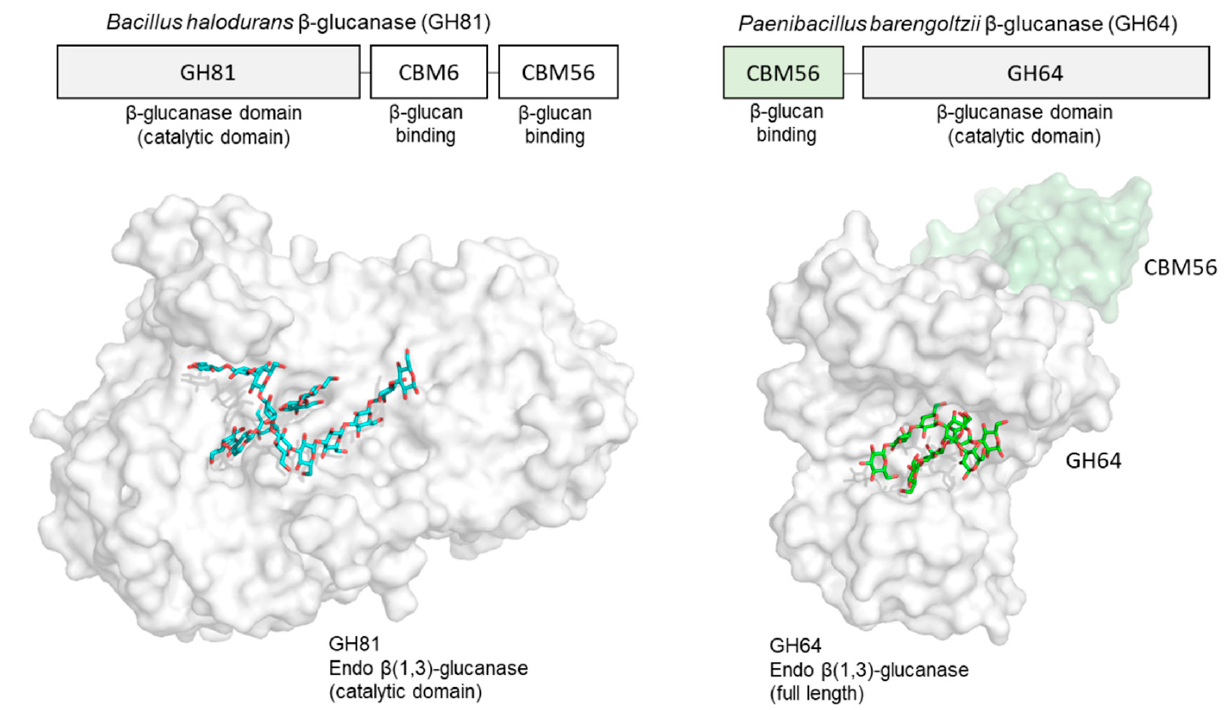
Figure 5. Crystal structure of endoglucanases bound to β -glucan chains. GH81 endo β -1,3-glucanase in complex with three β -glucan chains (DP = 10, 3, 2) derived from laminarin (PDB ID: 5T4G) (left) and GH64 endo β -1,3-glucanase in complex with two laminarihexaose chains (PDB ID: 5H9Y) (right). Proteins are shown in surface model and β -glucan chains in stick representation.